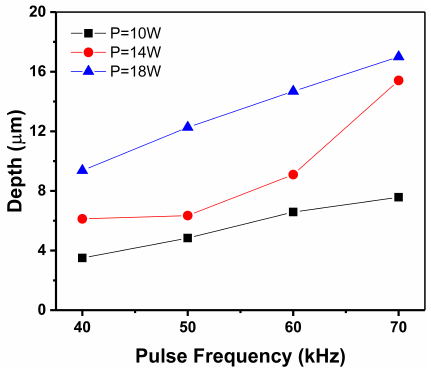
Figure 5. Effect of laser power and pulse frequency on D. Table 5. ANOVA results of D.